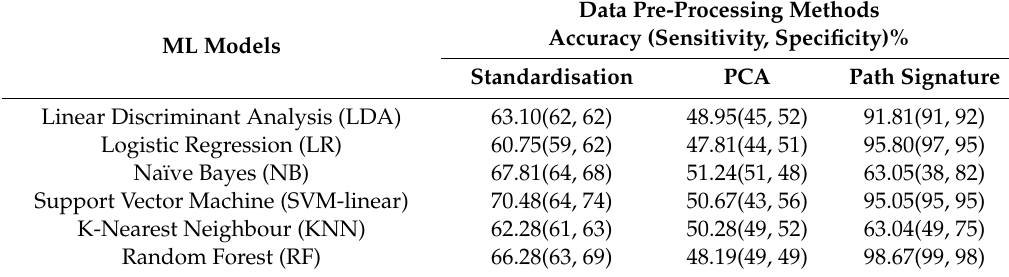
Table 2. Accuracy, sensitivity and specificity of ML